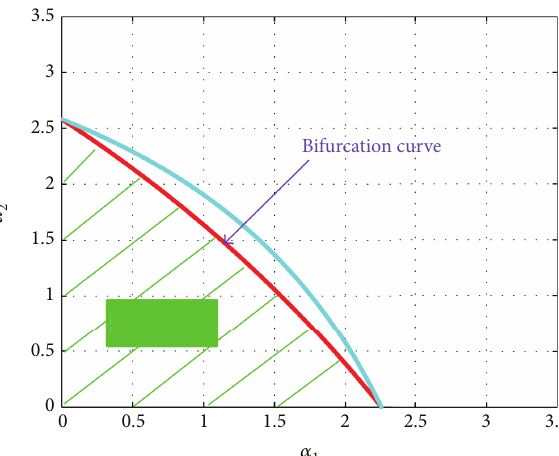
Figure 1: The stable region of Nash equilibrium point about 𝛼 1 and 𝛼 2